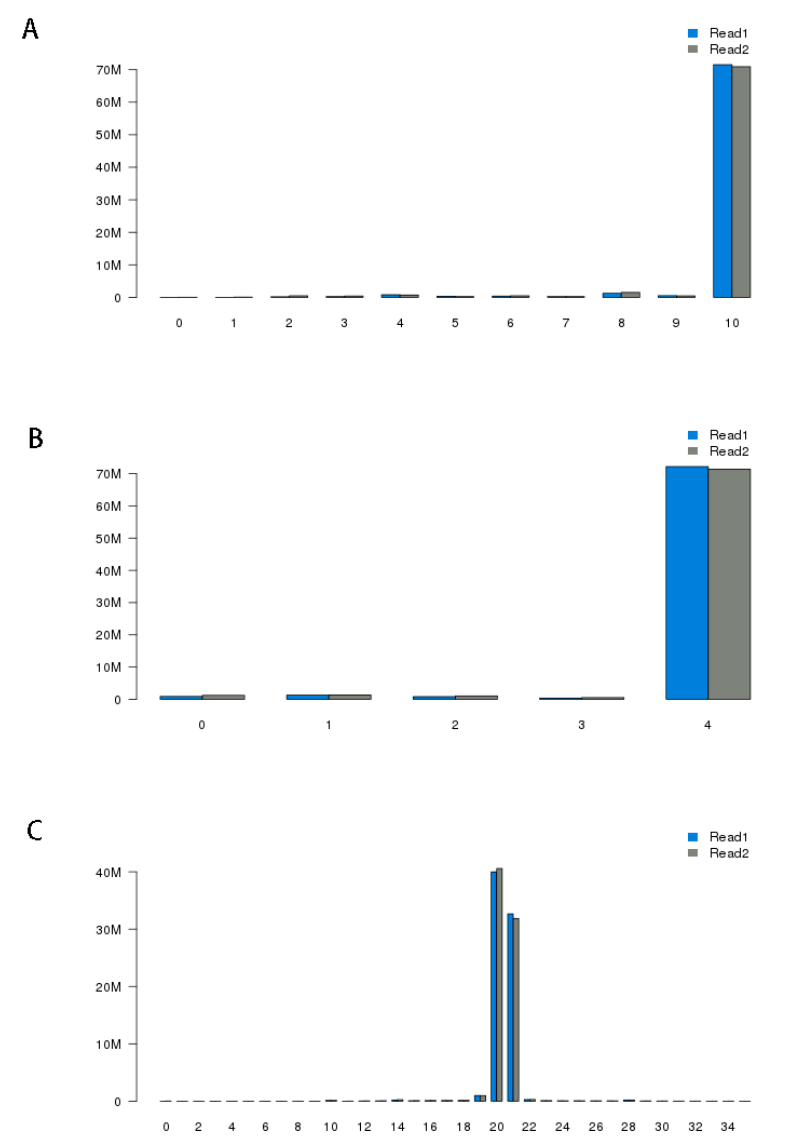
Figure A1. Statistics from linker filtering. ( A ) Distribution of linker alignment scores. Most of the linker alignment scores are 10, which is expected due to the design of the linkers. ( B ) Distribution of linker alignment score differences between the best-aligned linkers and the second-best-aligned linkers. ( C ) Distribution of tag lengths. Most tags after trimming the linker sequences are 20bp or 21bp long, which is expected from enzyme MmeI’s digestion property. Table A1. Example of peak file.